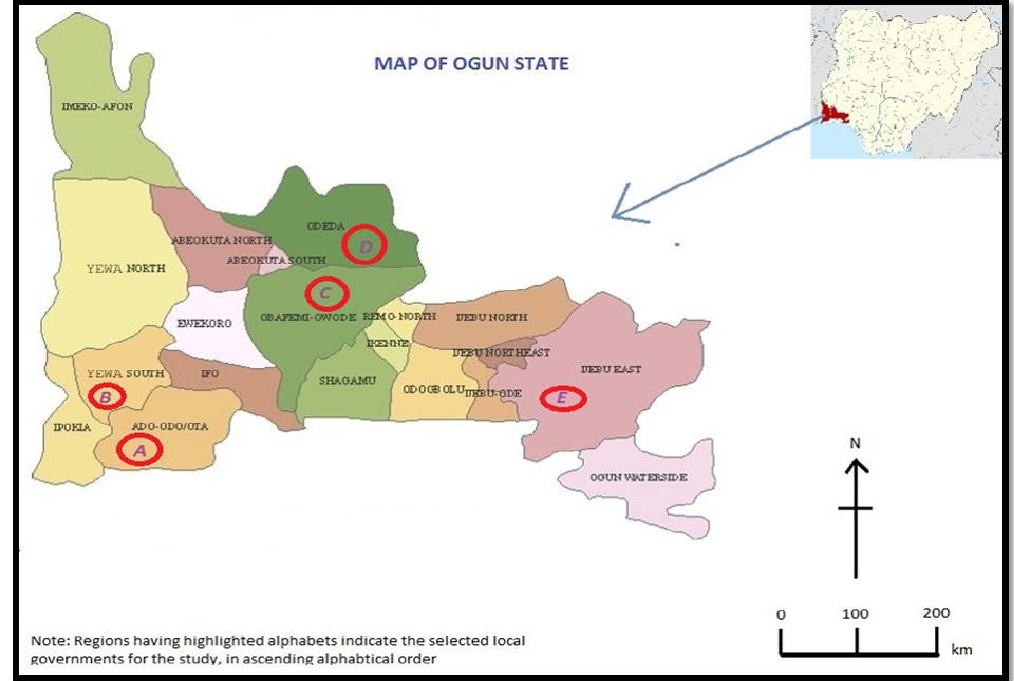
Figure 1. Map of Ogun State, showing its various local government areas. Adapted from [6].